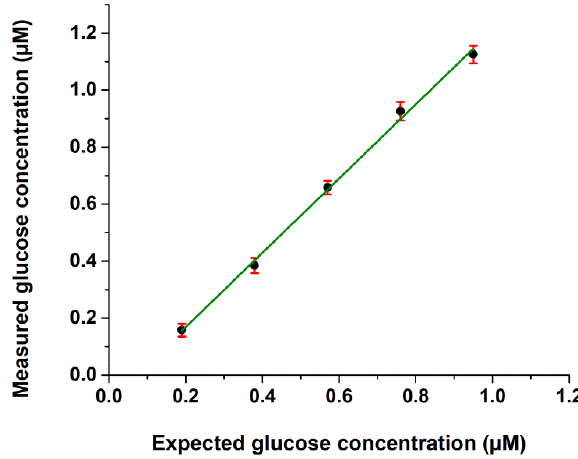
Figure 2. Linearity of the glucose assay. Linearity was calculated by diluting cell extracts within the range of 20–100% of their original glucose concentrations using five different dilutions. The linear regression equation is: y = 1.2381 x − 0.0925, R 2 = 0.9974. Mean values of three parallel measurements (eight technical replicates for each dilution) are demonstrated.